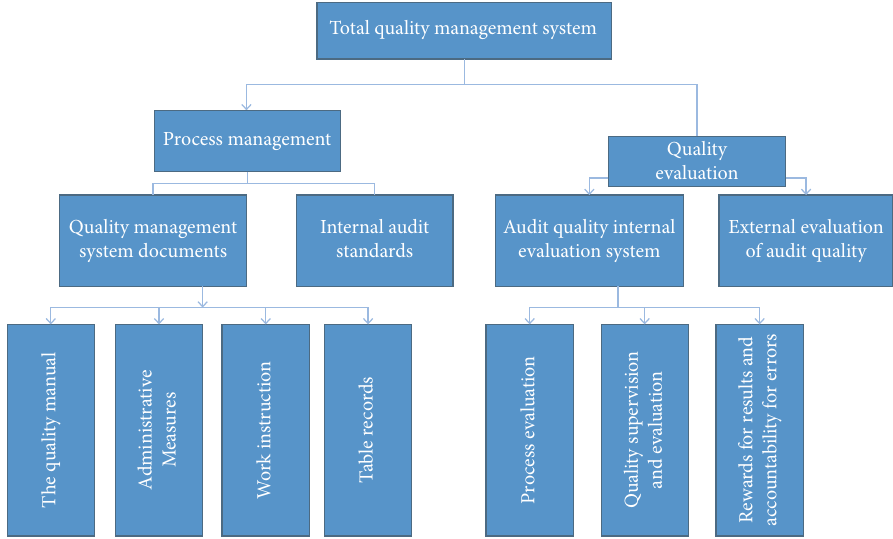
Figure 3: Contents of the total quality management system of insurance company A Table 1: Internal audit on-site and off-site audit days of insurance company A .